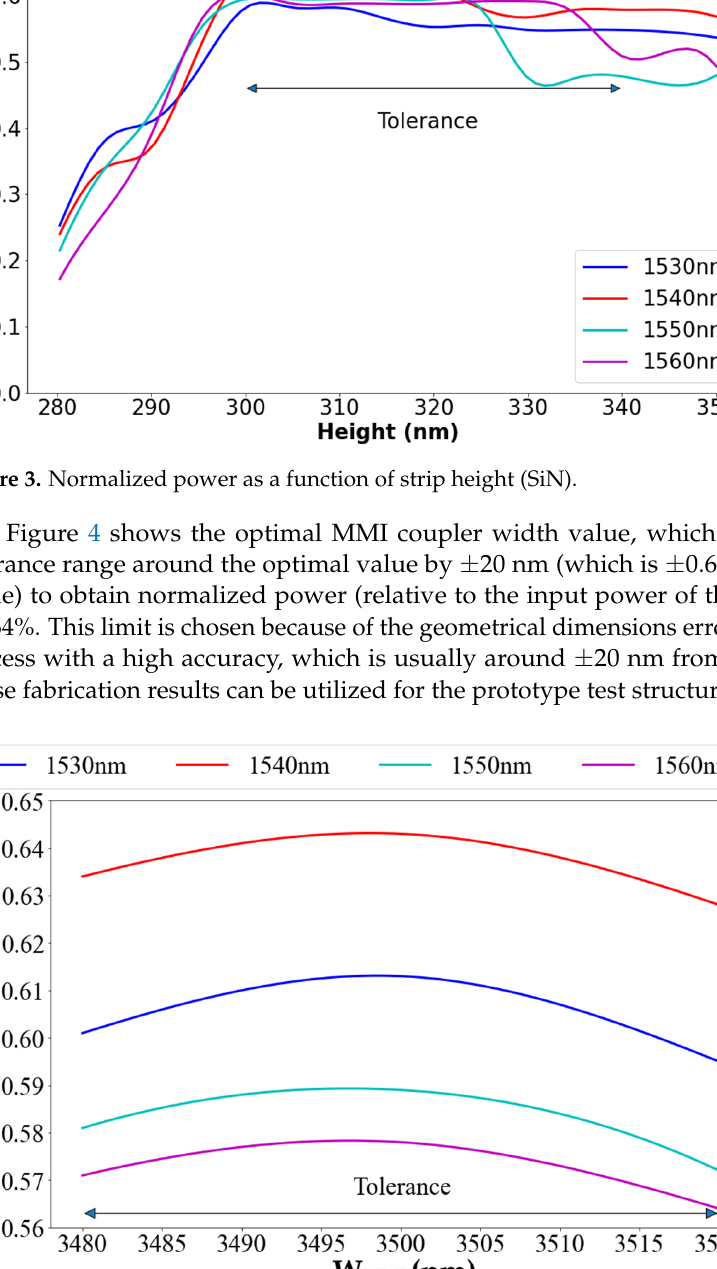
( b ) Figure 2. ( a ) TE fundamental mode for 1530 nm and ( b ) its horizontal cut, where Y = 0.15 μ m. The effective refractive indexes (n eff ) values were calculated and found by solving the fundamental mode for each of the operating wavelengths, as shown in Table 1. Table 1. The effective refractive index values for the operating wavelengths. λ (nm)